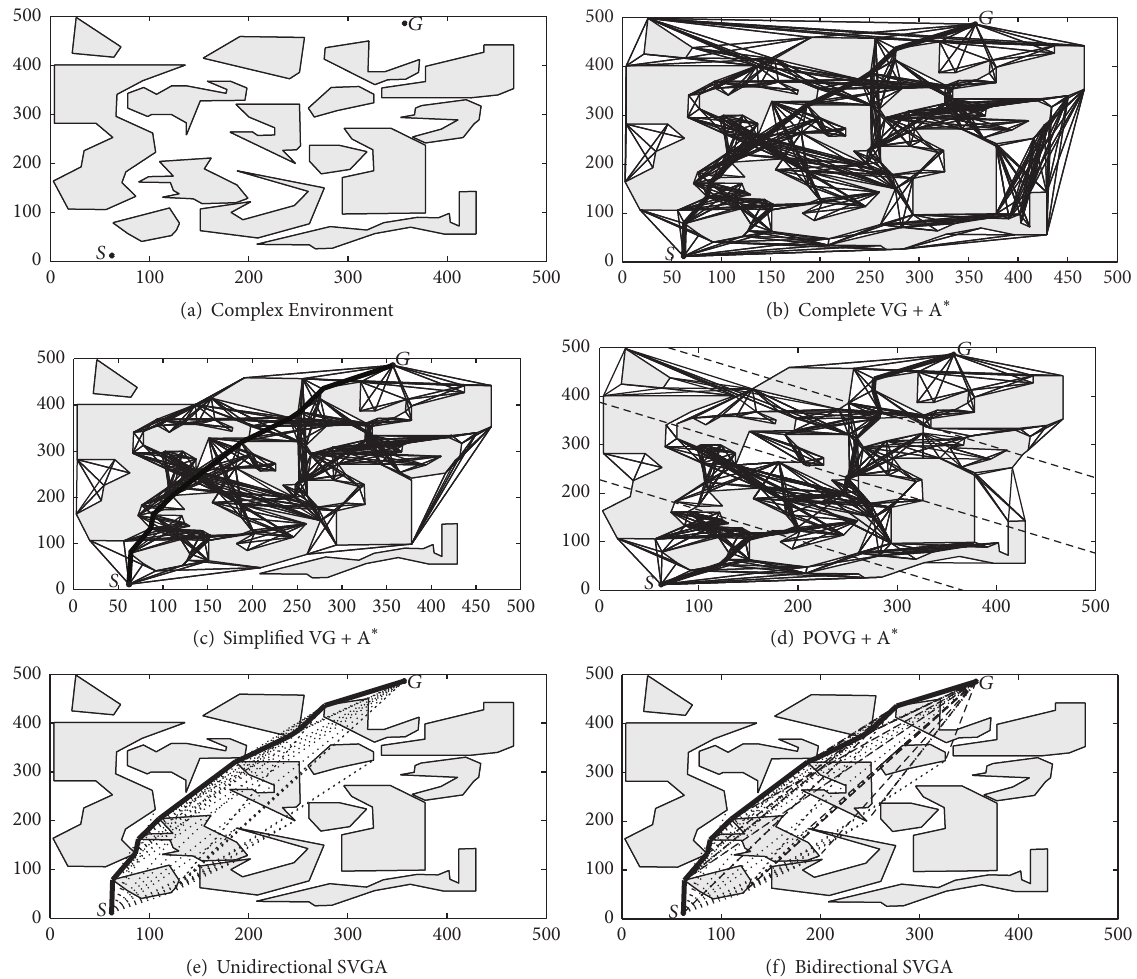
Figure 5: Comparison between five algorithms in a complex